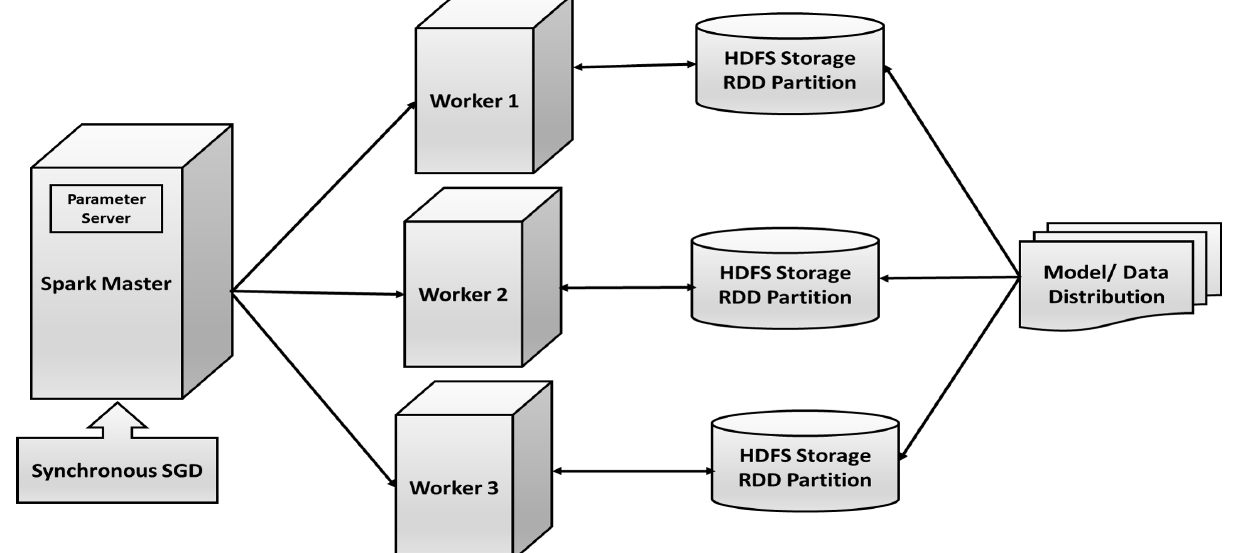
Figure 8. General architecture of Distributed Apache Spark and deep